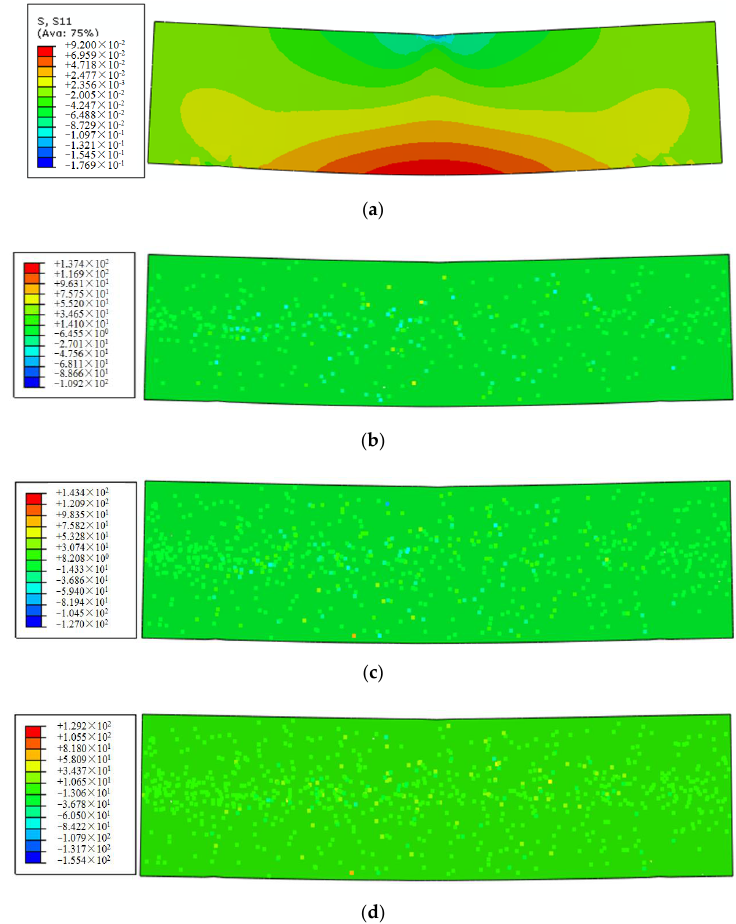
Figure 14. Stress contours of longitudinal section under different BF contents at 3600 s as: ( a ) the control; ( b ) 0.1% fiber content; ( c ) 0.2% fiber content; ( d ) 0.3% fiber content. Polymers 2020 , 12 , x FOR PEER REVIEW